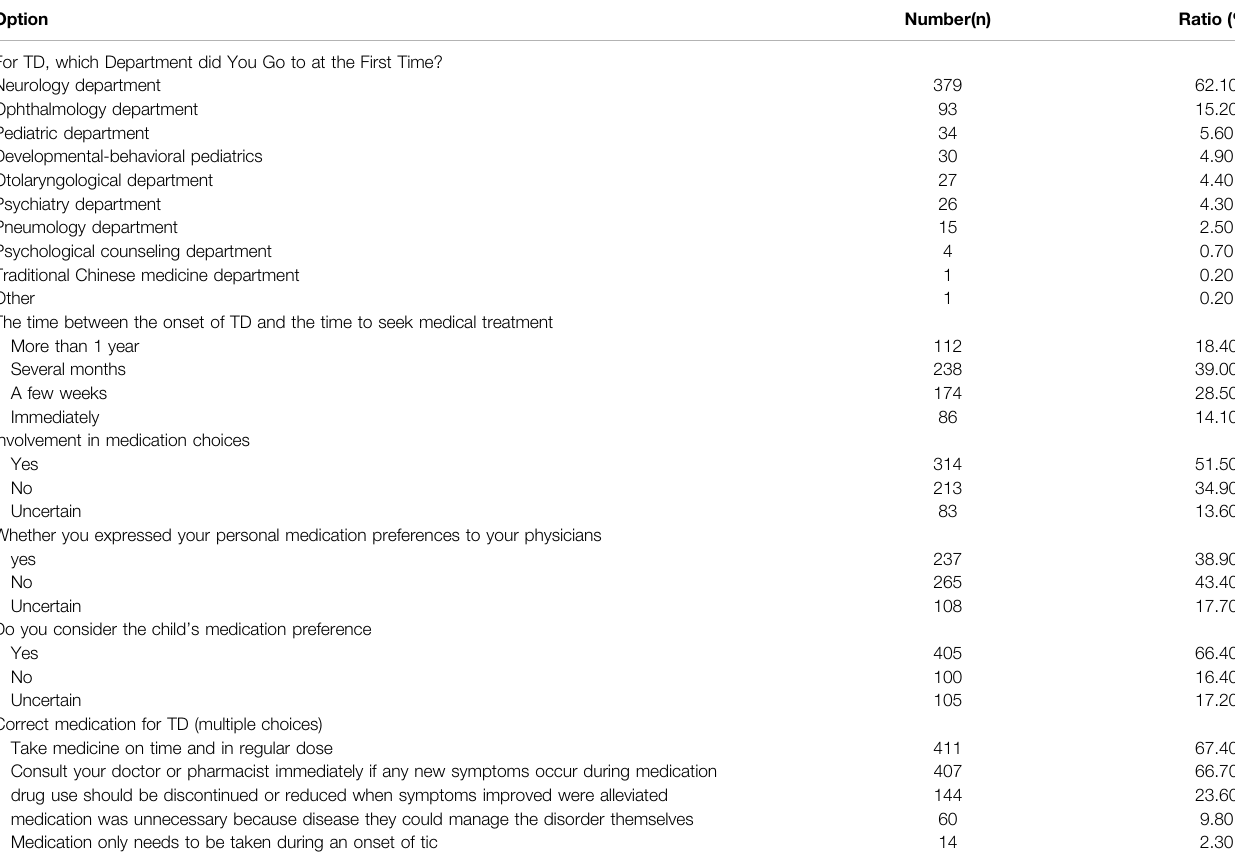
TABLE 6 | Guardian ’ s medical behavior and medication choices (N = 610).